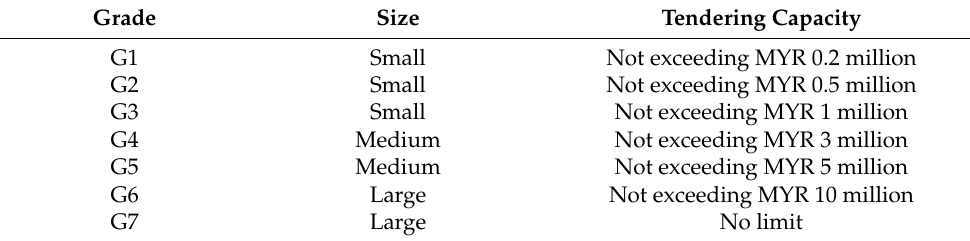
Table 1. Contractors’ classification in Malaysia (adapted from Reference [31]).